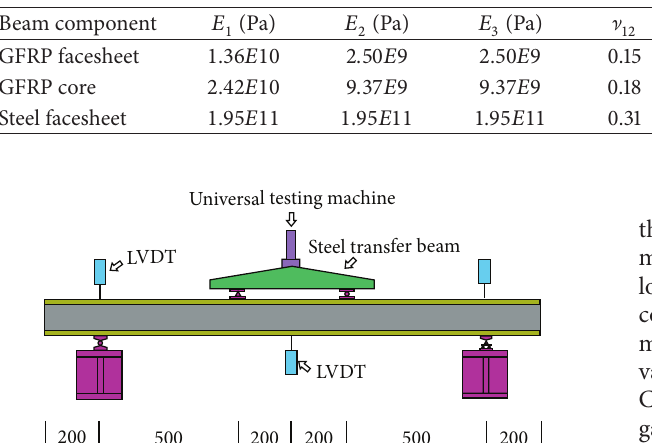
Table 3: The material properties of GFRP and steel.